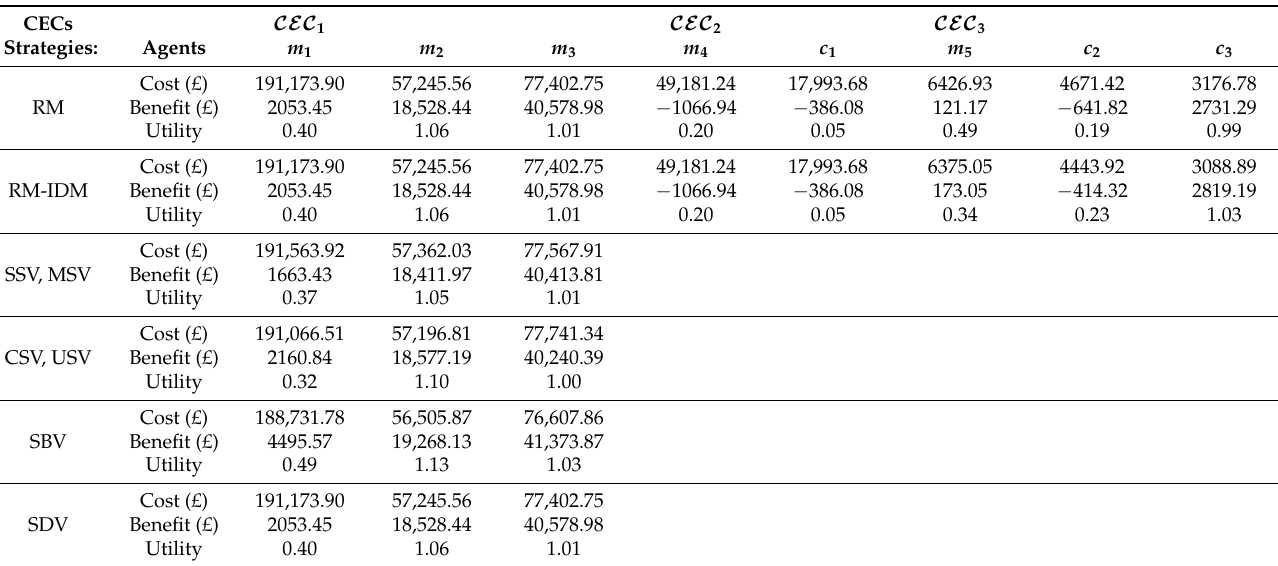
Table 6. Results of the case study: point of view of the